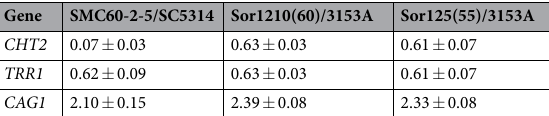
Table 3. Expression change a of CHT2 , CAG1 or TRR1 carried on the monosomic Ch5. vs normal disomic Ch5 of the corresponding parental strain, as determined with semi-quantitative RT-PCR from three independent RNA preparations b . a Expression change was determined as averaged ratio mutant/parent ± SD. b The differences in expression between mutants and parentals, SC5314 or 3153A, were evaluated with Student’s t test showing all p-values <